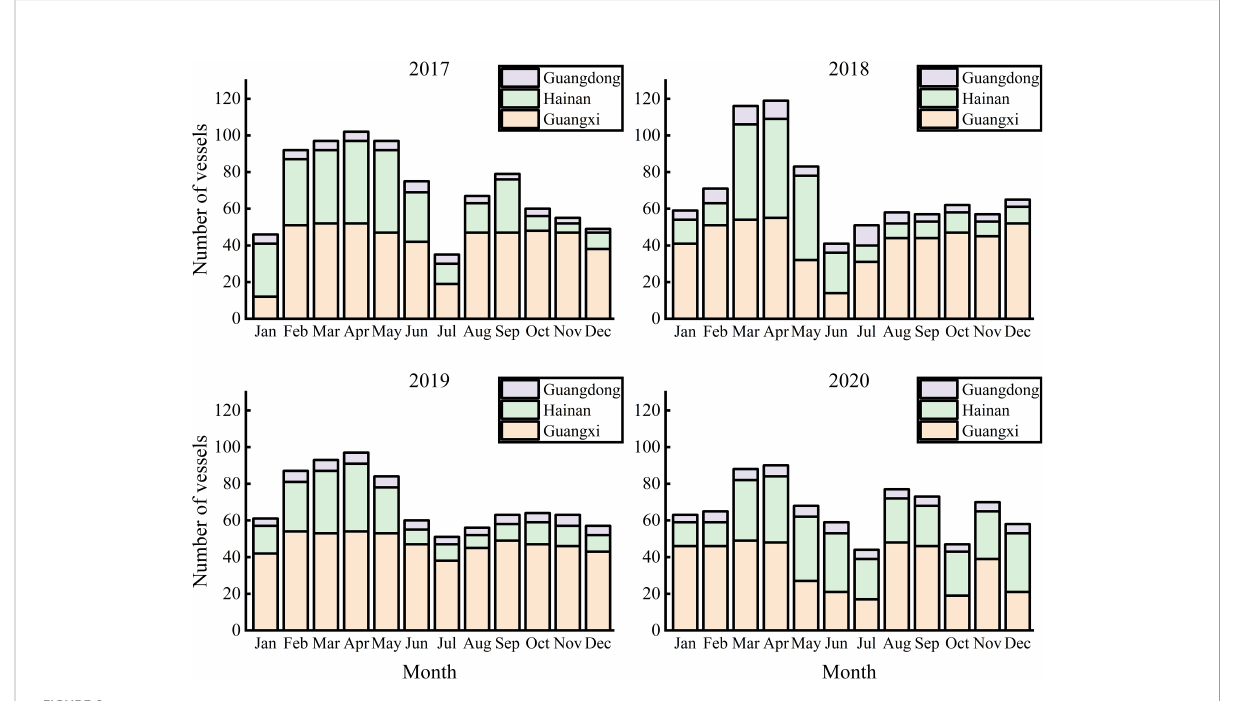
FIGURE 2 Monthly maximum numbers of fi shing vessels obtained from vessel monitoring information.